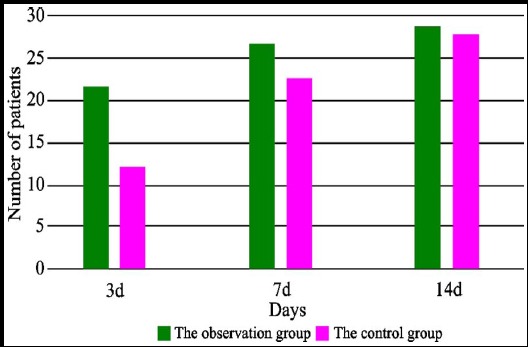
The number of patients who went off from bed for the first time from the 3rd day to 14th day after operations